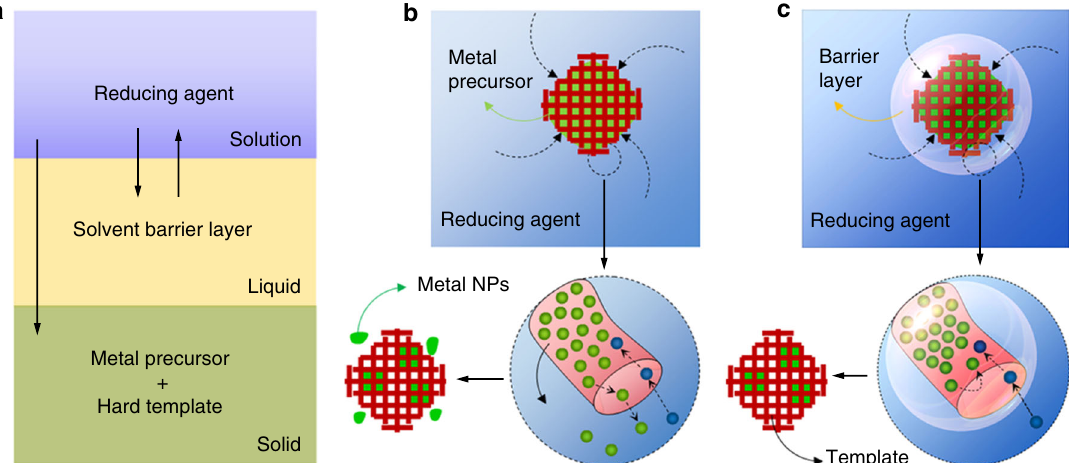
Fig. 1 The schematic illustrations of soft-enveloping strategy. a The proposed SLS (solid – liquid – solution) three phase interface, in which a solvent ( “ liquid ” ) that cannot dissolve metal precursors was used as a surface coating and a barrier layer to prevent metal species from migrating to the outside of the mesoporous channels ( “ solid ” ). Next, the transfer of the reducing agent ions ( “ solution ” ) across the solvent and then the reduction of the metal precursor at the interface of the “ solid ” and “ solution ” . b The present challenge is that the fi nal product mixes with the morphologies containing the bulk particles. c The current soft-enveloped SLS interface reaction